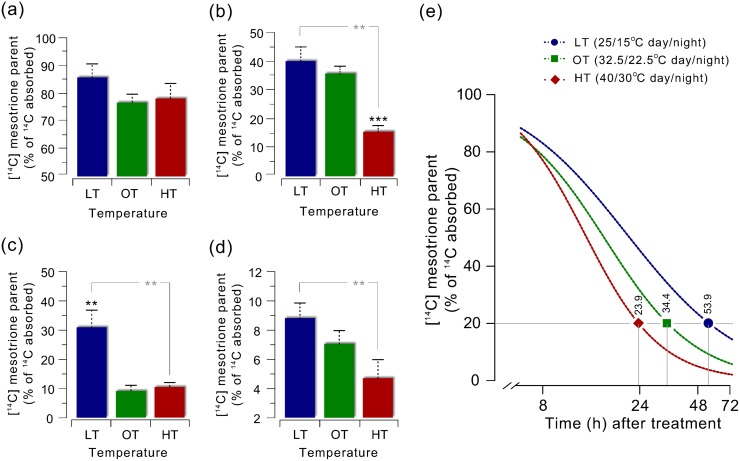
Parent [14C] mesotrione remaining in Palmer amaranth (whole aboveground part) plants under three different temperatures (low temperature, LT, 25/15°C; OT, optimum temperature, OT, 32.5/22.5°C; and high temperature, HT, 40/30°C; 15/9 h day/night).(a) 8, (b) 24, (c) 48, (d) 72 h after treatment as determined by reverse-phase HPLC, and (e) time course of mesotrione metabolism. All Palmer amaranth plants (10 to 12 cm tall, 8 to 10 leaf stage) were treated with 8- x 2.5-μL droplets (1.6548 mM mesotrione, 0.85% w/v AMS, and 1% COC) containing 7.2 kBq of [14C] mesotrione on the upper surface of fourth and fifth youngest leaves. Data represent means of three to five biological samples. Significant differences in mean values between OT and HT or LT are indicated with dark color asterisks, and between HT and LT with light color asterisks (*, P ≤ 0.05; **, P < 0.005). Error bars represent SE. Curves for [14C] parent compound (mesotrione) data were fitted using a three parameter log-logistic model.